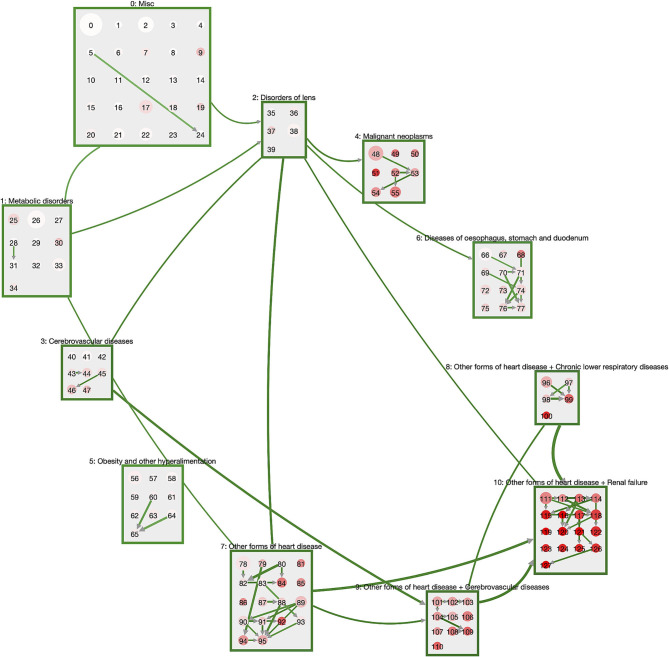
Trajectories of DM patients. The macro-clusters are shown as green squares containing a variable number of disease clusters. Cluster size is proportional to the number of patients in that cluster; color gives mortality (the more intense the red, the higher the mortality). We show links for transitions between macro-clusters or between clusters of the same macro-cluster with a weight (transition rate) of at least 0.007. DM patients typically start in the “Misc” cluster and progress via metabolic disorders and eye diseases toward heart diseases that combine with respiratory and cerebrovascular diseases, as well as renal failure.